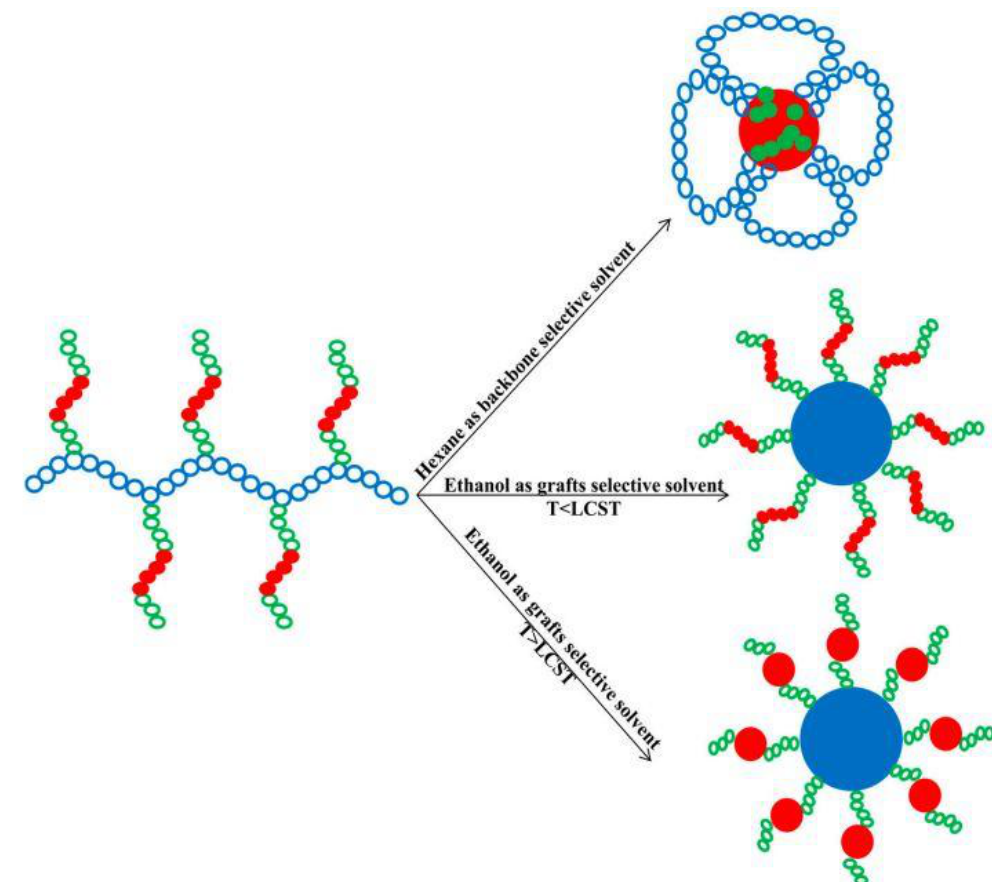
Figure 10. Micellar conformations of PI- g -Pluronic copolymers in hexane (backbone selective solvent) and in ethanol (grafts selective solvent). Adapted from Alexander et al. [116].